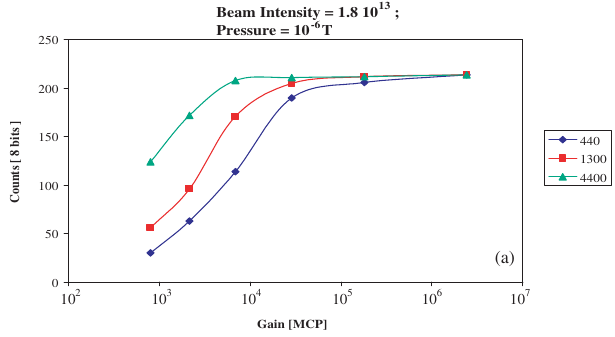
FIG. 10. (Color) CCD counting vs MCP gain for different beam sizes. They decrease as a function of the timing event in the ramp ( T (cid:6) 440 (cid:6) larger sizes, T (cid:6) 4400 (cid:6) smaller sizes). The figure displays the count variation versus the MCP